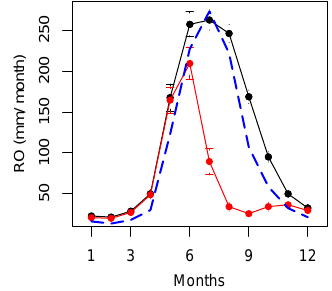
Fig. 4. Simulated mean monthly runoff (RO) at gauge Brunau with confidence interval bars using downscaled climate data from 2055 to 2099 with constant glacier coverage (black) and complete loss of glaciers (red). Measured mean monthly runoff from 1986 to 2008 is plotted in